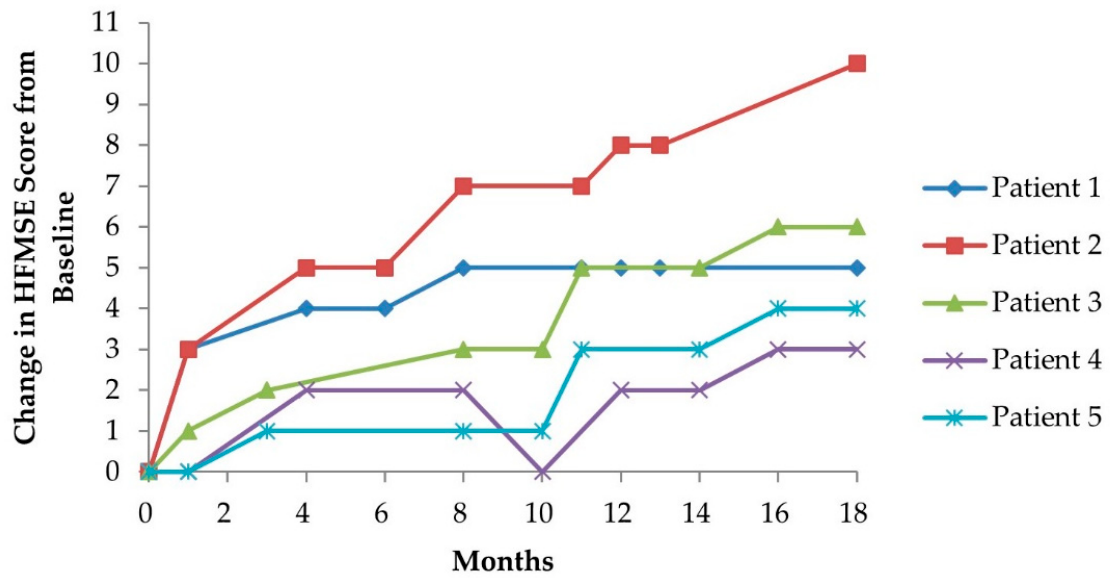
Figure 1. Change in HFMSE score from baseline to 18 months after nusinersen injection. HFMSE—Hammersmith Functional Motor Scale (expanded version).